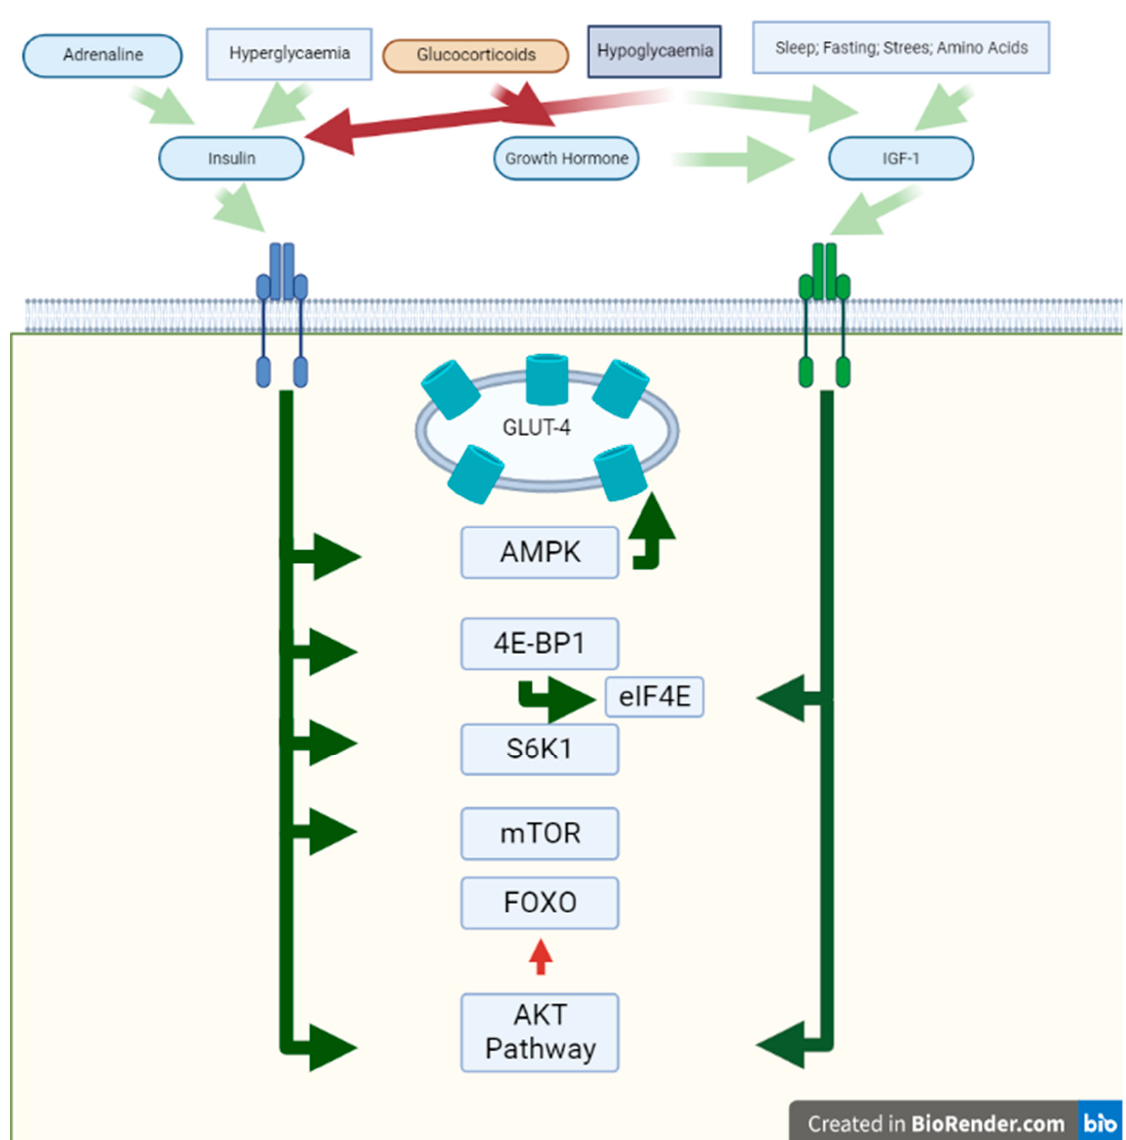
Figure 1. Anabolic effects on muscle. In this figure, the effects of activation of Insulin Receptor and IGF-R are shown. The white background represents the extracellular space, the green bar the sarcomere membrane, and the green background the cytosol. Red squares represent signals with an inhibitory effect and green squares represent stimulatory ones. The blue square represents hypoglycaemia, which has both inhibitory and stimulatory effects. Green arrows represent the stimulatory effect and red arrows represent the inhibitory effect on different proteins and pathways. Abbreviations: IGF-R: insulin-like growth factor receptor; AMPK = AMP-activated protein kinase.